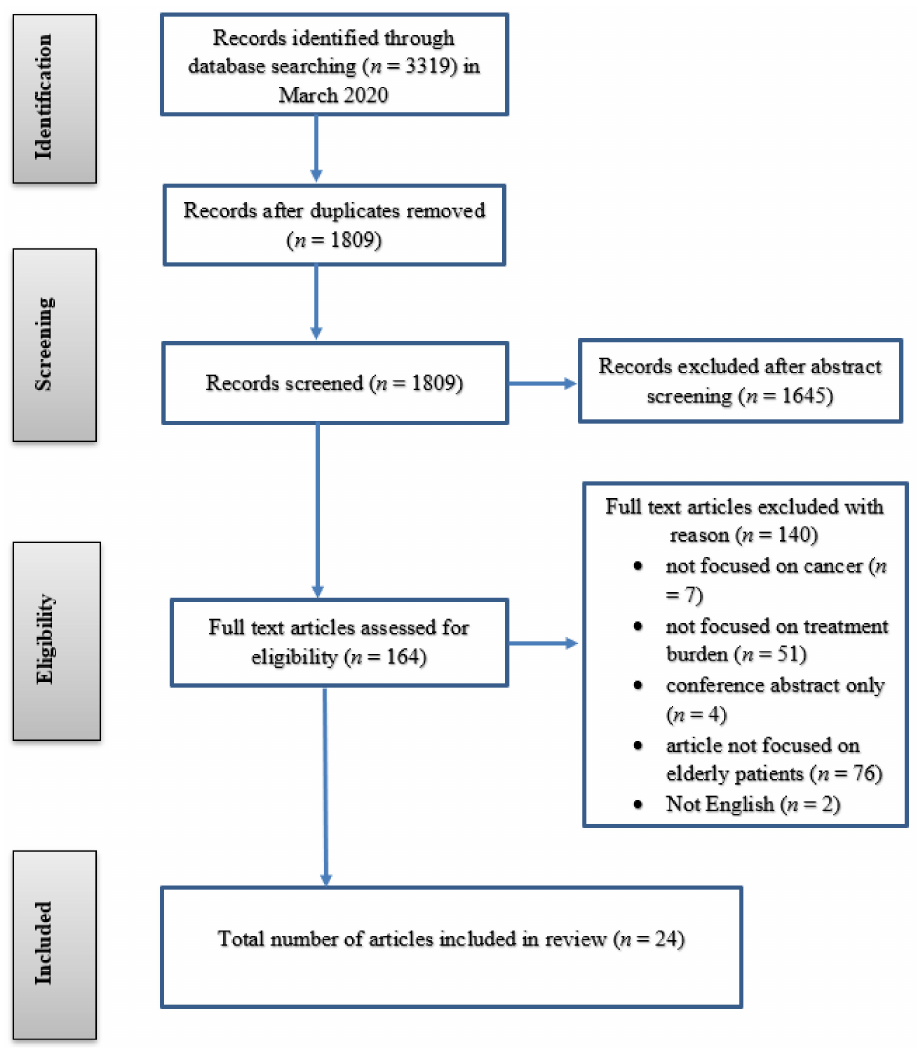
Figure 2. Inclusion